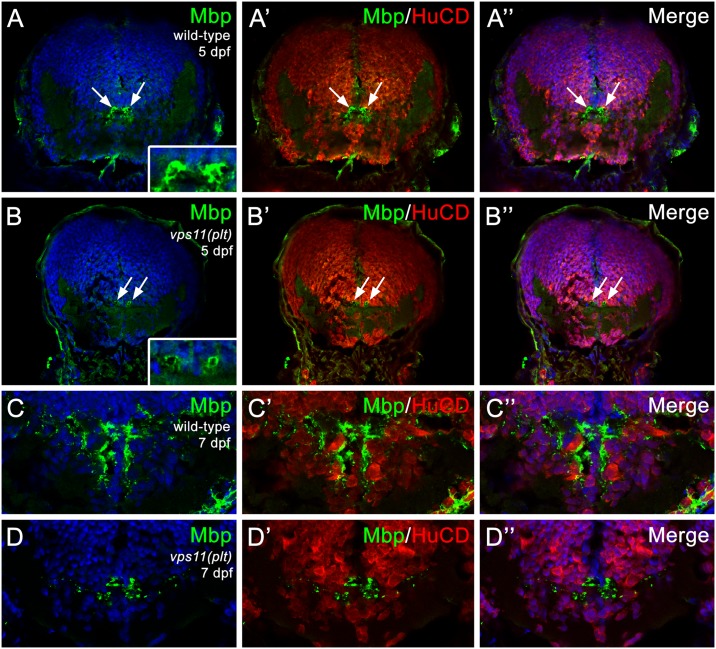
Progressive loss of myelination in zebrafish vps11(plt) mutants.Cryosectioned CNS tissue from vps11(plt) mutants and wild-type siblings were immunolabeled with Mbp (myelin; green) and HuCD (neurons; red) at 3 and 5 dpf. (A-A”) Mbp immunolocalization to Mauthner axons in the hindbrain of wild-type animals at 5 dpf (arrows). (B-B”) Mbp immunolocalization to Mauthner axons in the hindbrain of vps11(plt) mutants at 5 dpf (arrows). (C-C”) Mbp immunolocalization in the hindbrain of wild-type animals at 7 dpf. (D-D”) Significant reduction in Mbp immunolocalization in the hindbrain of vps11(plt) mutants at 7 dpf.